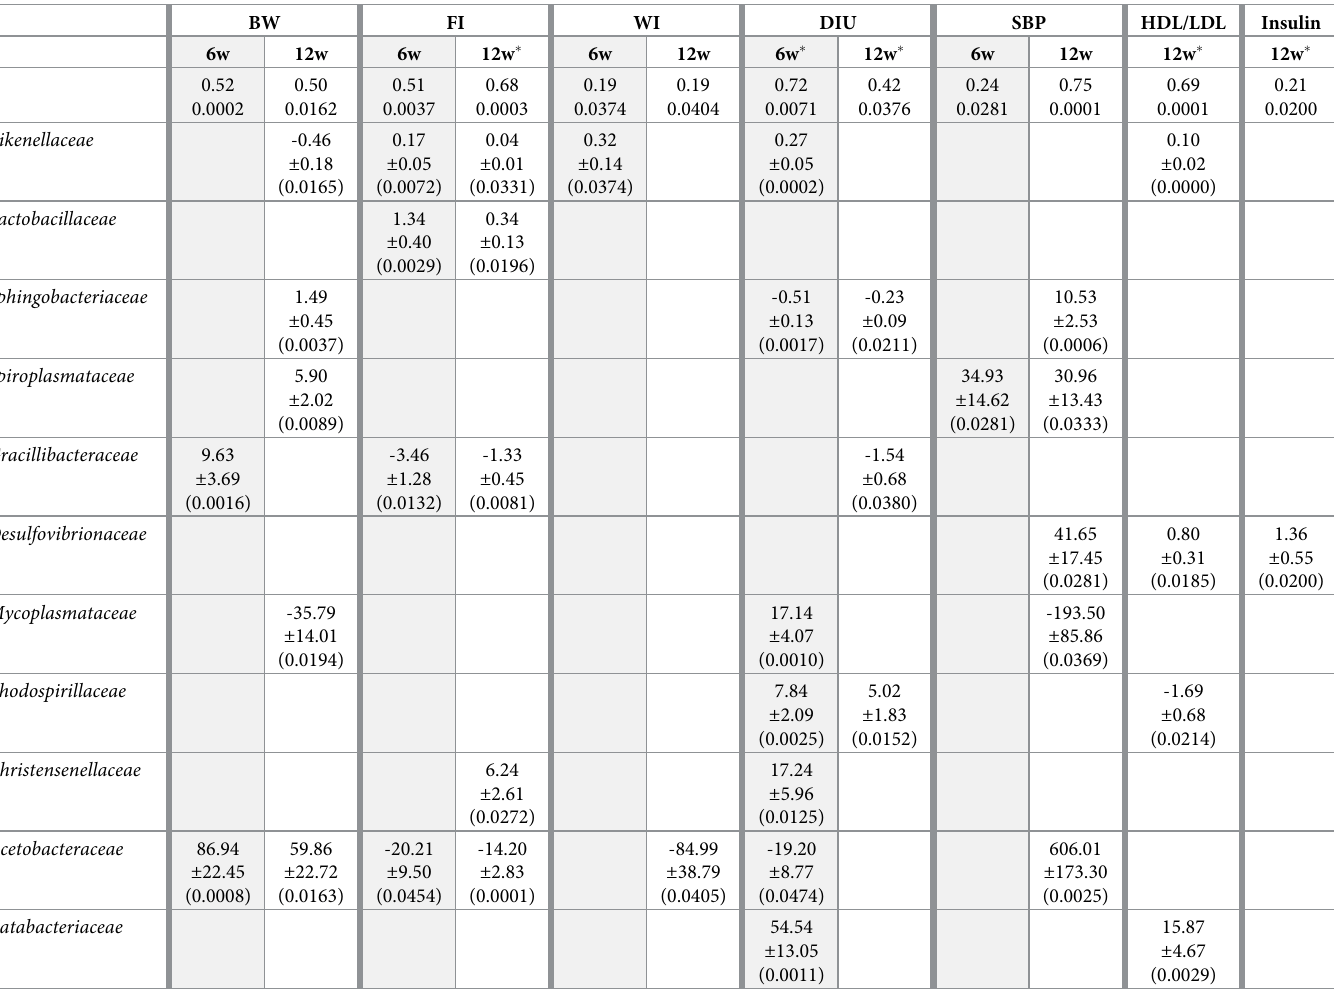
For each case, regression coefficient estimate, s.e. and p values are shown. R 2 and p values of the model are also indicated under each physiological variable. � indicates that logarithms of data have been used for the analysis. BW, body weight; FI, food intake; WI, water intake; DIU, diuresis; SBP, systolic blood